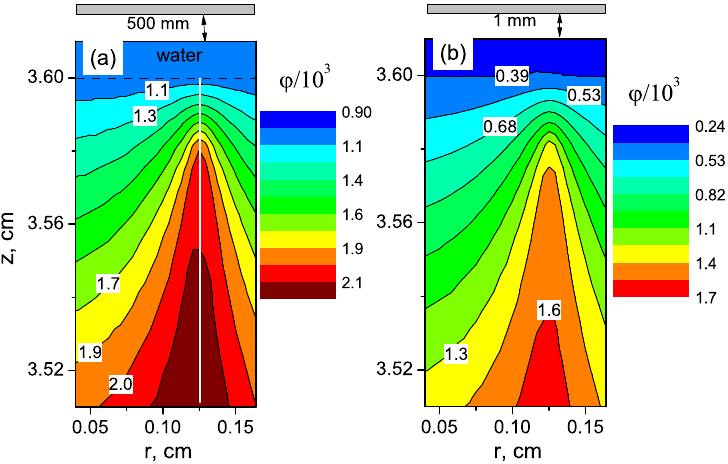
Figure 9. Spatial distributions of electric potential ( a ) without the GR substrate, color palette is for 900–2100 V, and ( b ) with the GR substrate, color palette is for 240–1700 V, argon, U = 4.9 kV. The potential profiles (over white line in Figure 9a) for different times during the streamer approaching the surface is shown in Figure 10 for the cases with and without the GR substrate. A higher electrical field near the liquid surface for the case with the GR substrate is provided with a steeper potential drop compared to the case without the GR